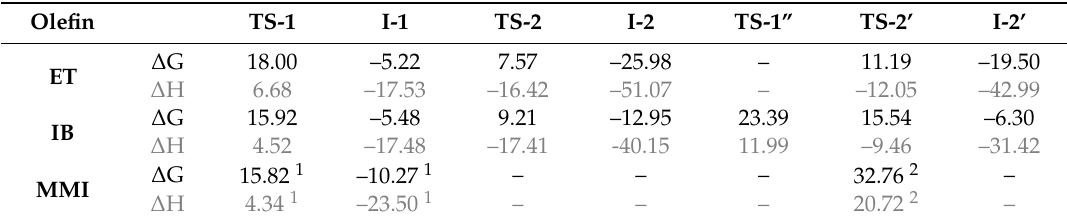
Table 3. Calculated free energies and free enthalpies of the key intermediated and transition states